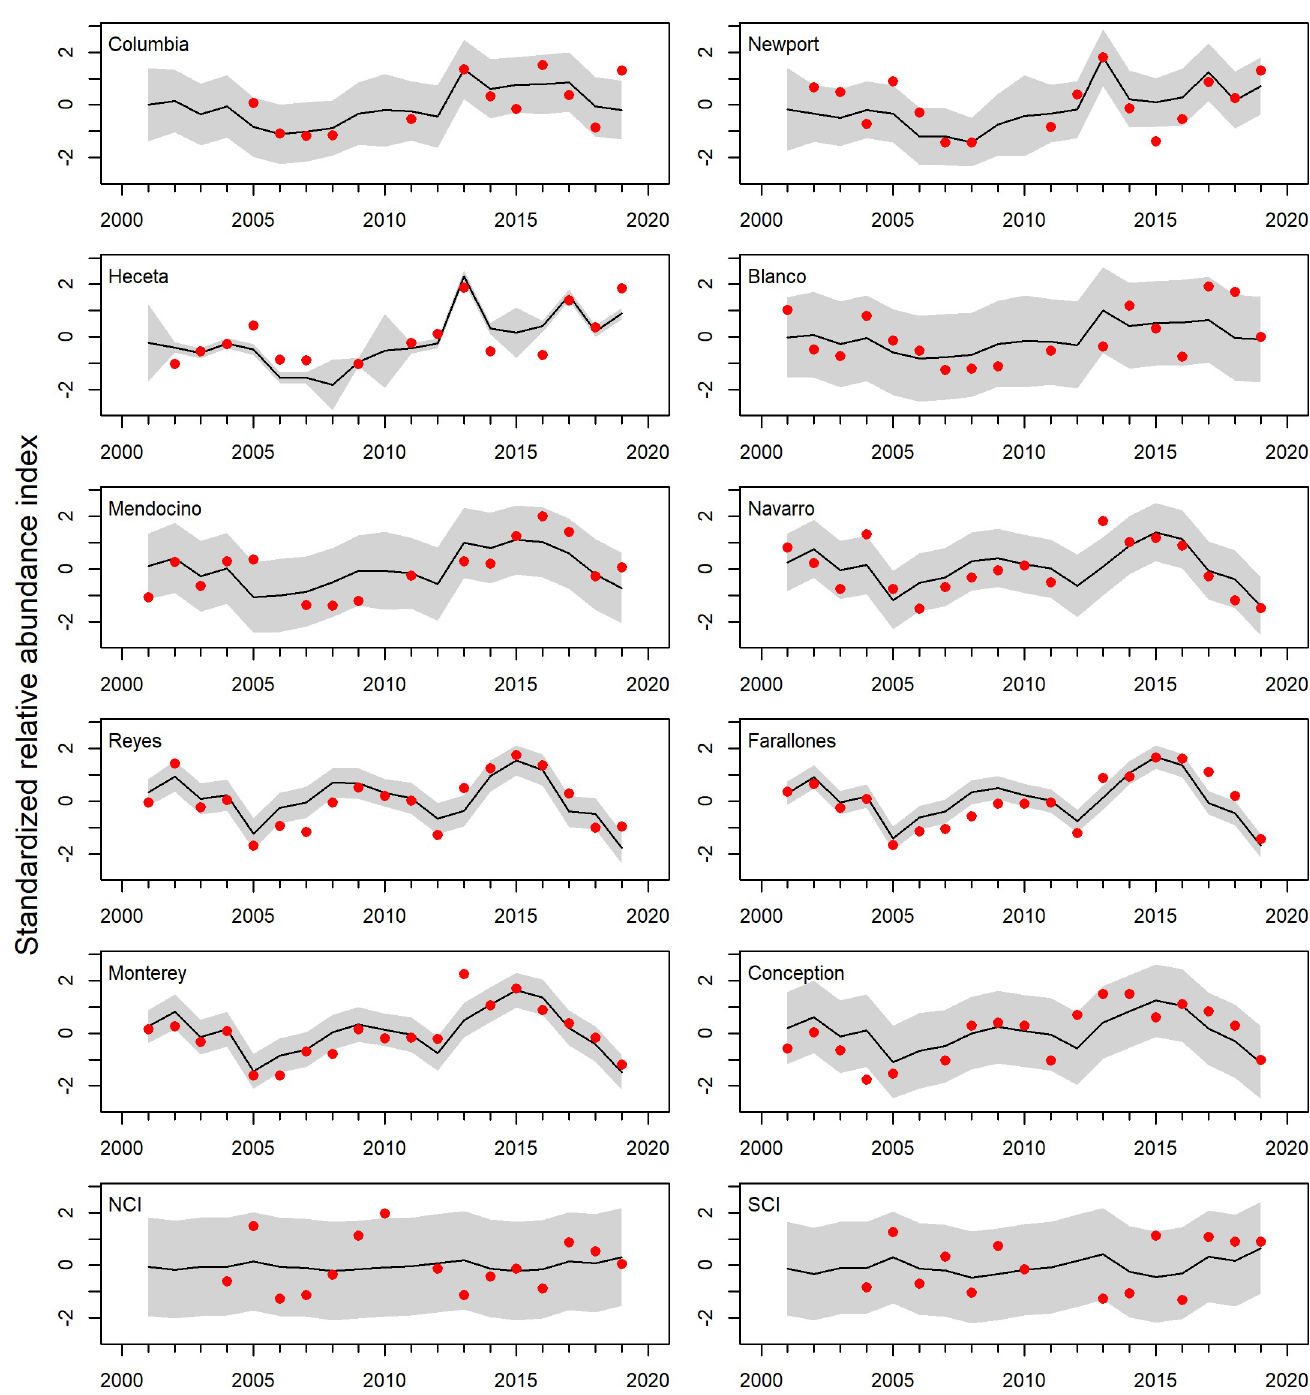
Fig 8. Fit of the two trend dynamic factor analysis to the regional catch rate data. Red dots are the observed estimates, the solid line is the dynamic factor analysis model estimate, and grey envelops are the 95% confidence intervals. Regions are ordered north to south.